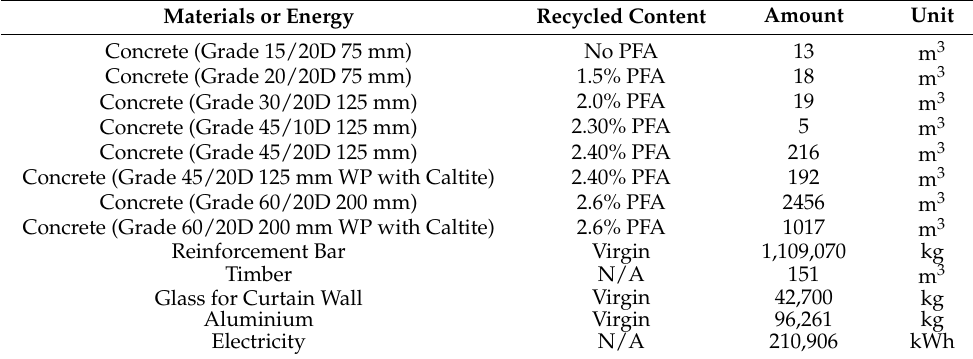
Table 1. Consumption of materials and energy for the residential building in the